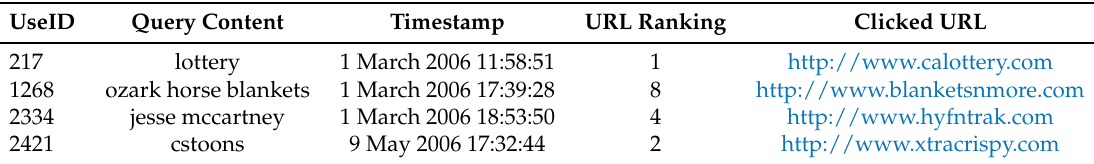
Table 2. Examples of AOL